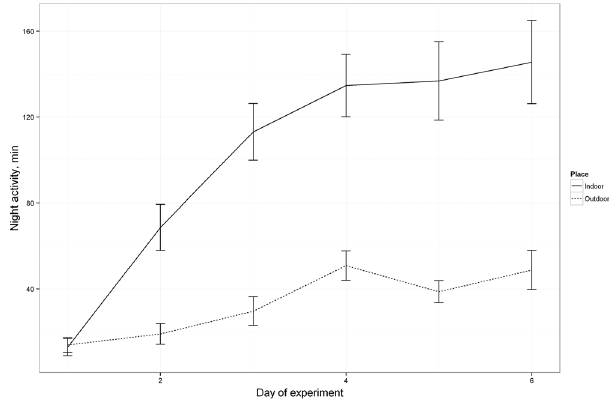
Figure 3. Development of nocturnal activity in groups, placed indoors and outdoors. The line represents a mean active period for all birds (in minutes per night) with error bars (SEM).